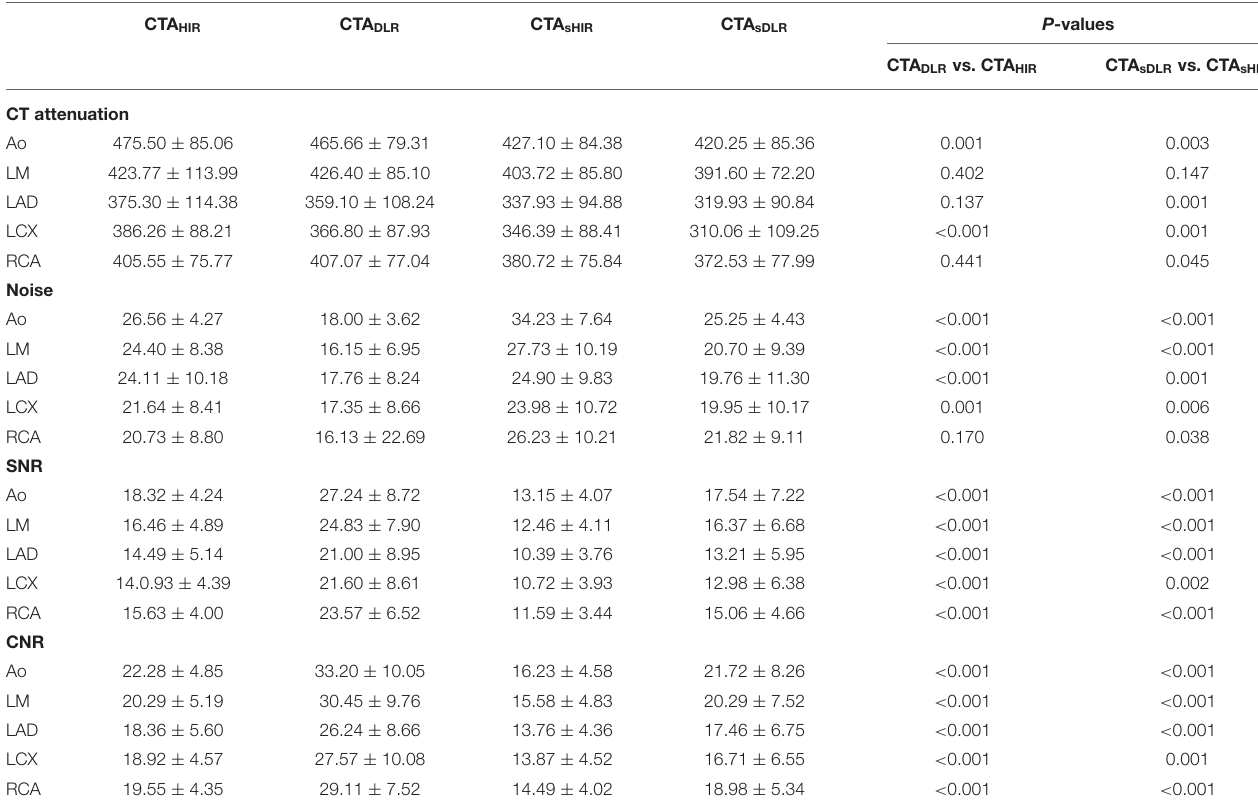
TABLE 3 | Quantitative image quality parameters.